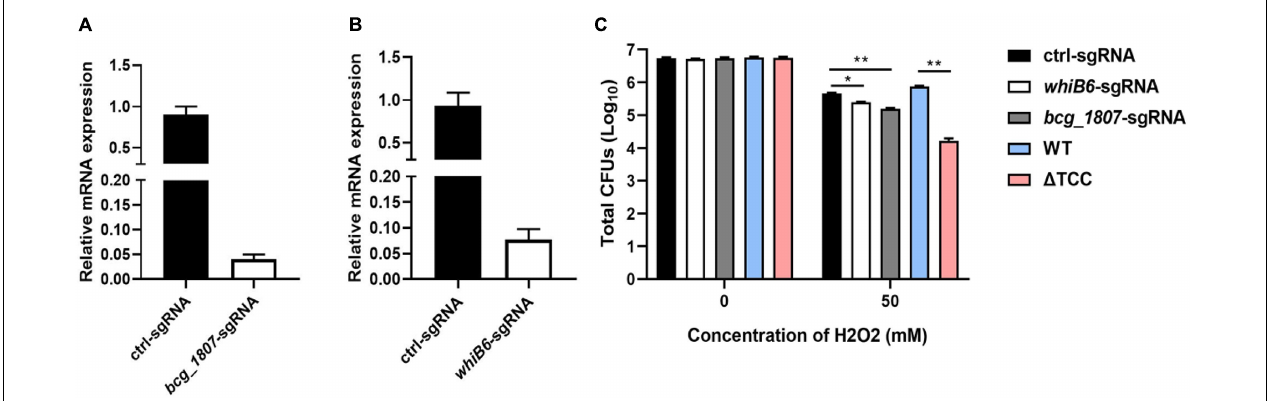
FIGURE 4 | Knockdown of TCC-regulated genes decreased the resistance of BCG to hydrogen peroxide. (A,B) Using CRISPRi to target gene silence. Bacteria was collected at logarithmic phase in the presence of ATc. Gene knockdown was quantified by qRT-PCR ( n = 3 biological replicates per each group, data are shown as the mean ± SEM). (C) Testing the survivability of knockdown strain. After induction, these knockdown strains were treated with 50 mM hydrogen peroxide. Bacteria strains were serially diluted 10-fold and spotted on 7H10-OADC agar. CFUs of M. bovis BCG were counted after 4 weeks days of incubation at 37 ◦ C ( n = 3 biological replicates per group, data are shown as the mean ± SEM by unpaired t -test with two tailed p -value; * p < 0.05, ** p <